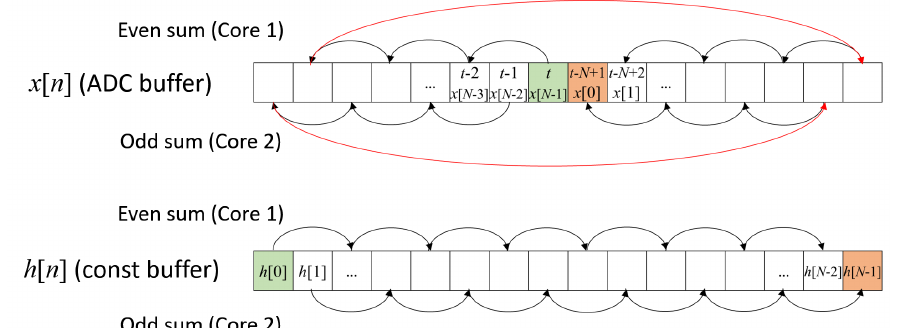
Figure 9. The sequence of the iterations performed to compute the convolution (2), split into two separate sums over the even and odd terms, respectively. The first term of the summation is indicated in green, that is, the memory location storing the last acquired sample, i.e., the sample at current time t . The last term is indicated in